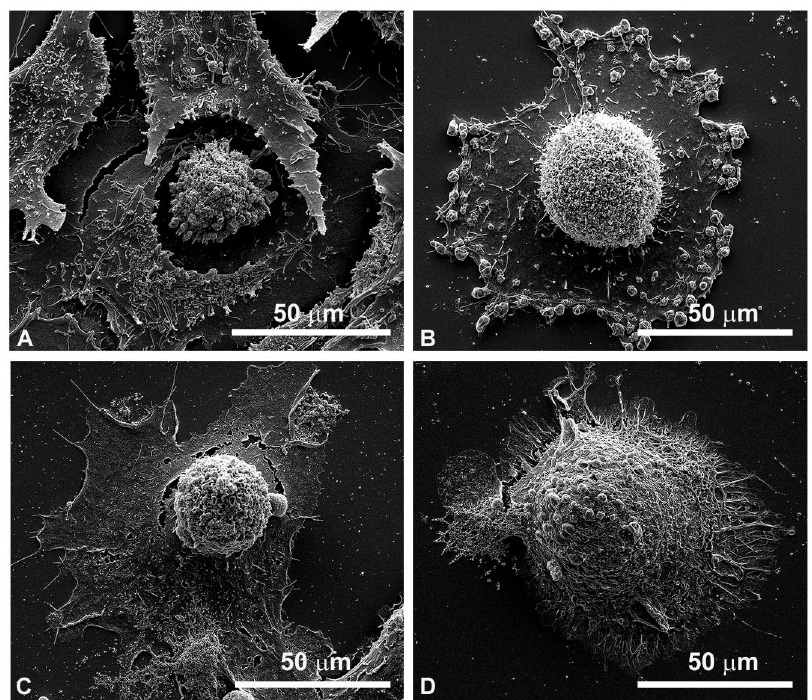
Figure 7. Details of individual cells by scanning electron microscopy after combined treatments (EP + MMC). ( A ) FaDu cells after 24 h; ( B ) CAL 27 cells after 24 h; ( C ) FaDu cells after 48 h; ( D ) CAL 27 cells after 48 h.